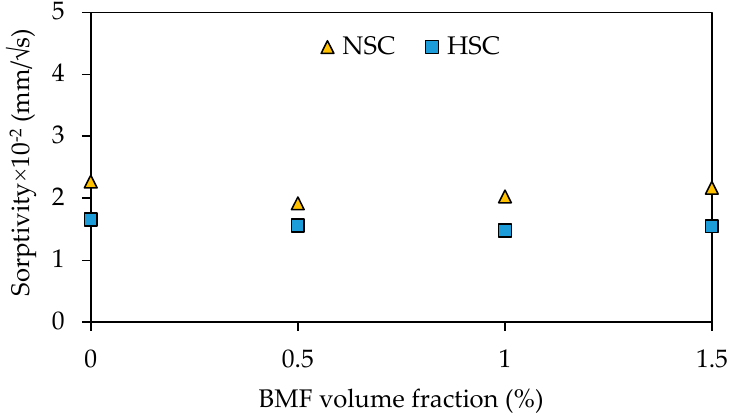
Figure 16. Sorptivity versus BMF volume fraction relationship.